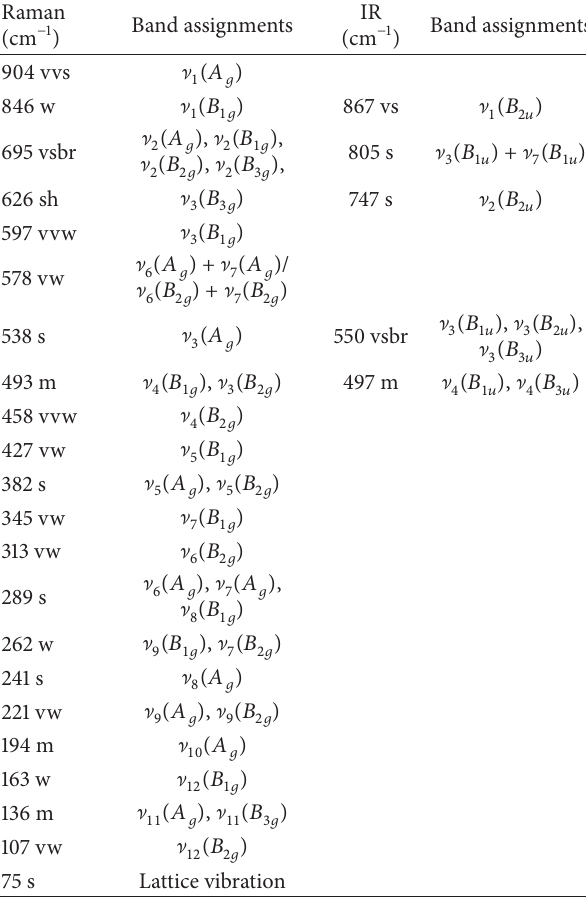
Table 1: Raman and IR spectral data of CaNb assignment relative intensities. v: very, s: strong, m: medium, w: weak, sh: shoulder, and br: broad.